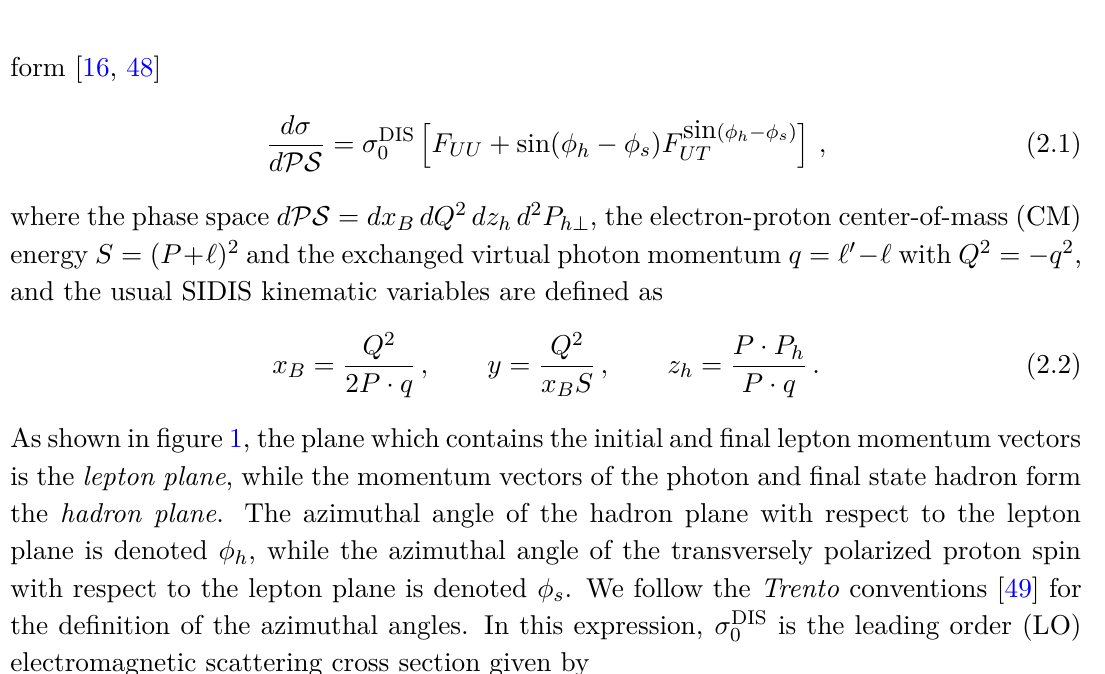
Figure 1 . Illustration of azimuthal angles in Semi Inclusive Deep Inelastic Scattering process